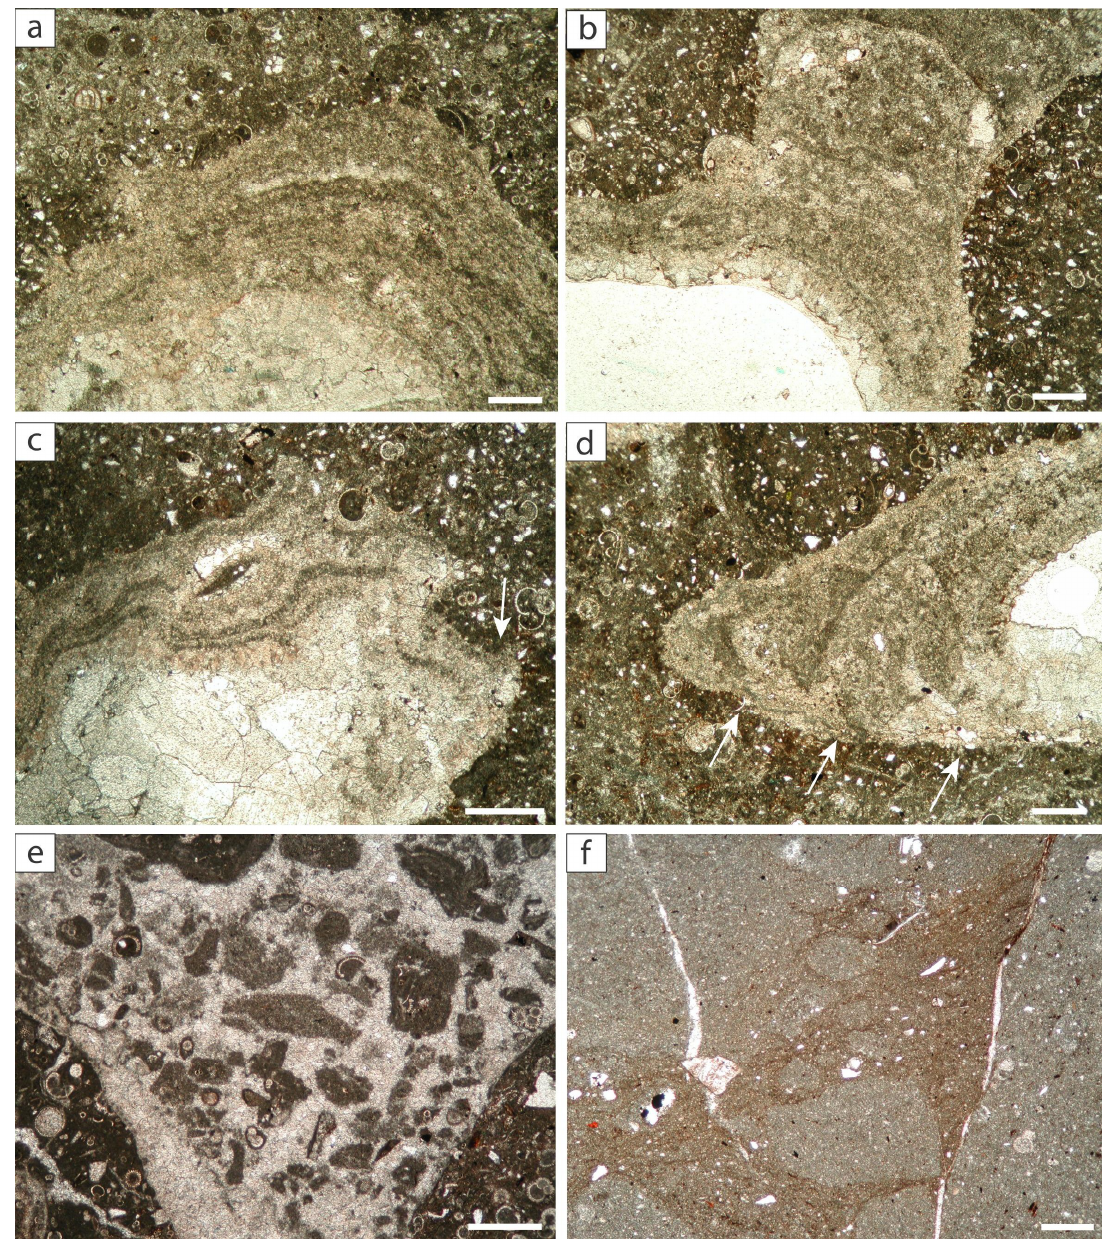
Figure 4. Micrographs displaying cavity infillings in the vuggy carbonate facies ( a,b,c,d ) and microbreccias ( e,f ). ( a,b ) Alternating laminae of microspatite and micrite. The thickness of the laminae varies from few microns to tens of microns. ( b ) Voids can be connected by conduits showing laminated fabric. Laminae do not line all the cavity wall but stop abruptly, in some cases producing pinch out terminations (white arrows; c , d ). Calcite cements and laminae may include some tests of foraminifera or siliciclastic grains, indicating precipitation in an early diagenetic stage within semi‐consolidated material. ( e ) Microbreccias composed by very angular and poorly sorted micritic clasts indicative of autoclastic fragmentation; clasts are floating in microsparitic cement. ( f ) Matrix‐supported microbreccias composed by subangular clasts of micrite; clasts seem to fit to each other. Thin sections from samples of PC and COR outcrops of Figure 1. Scale bar = 1 mm.